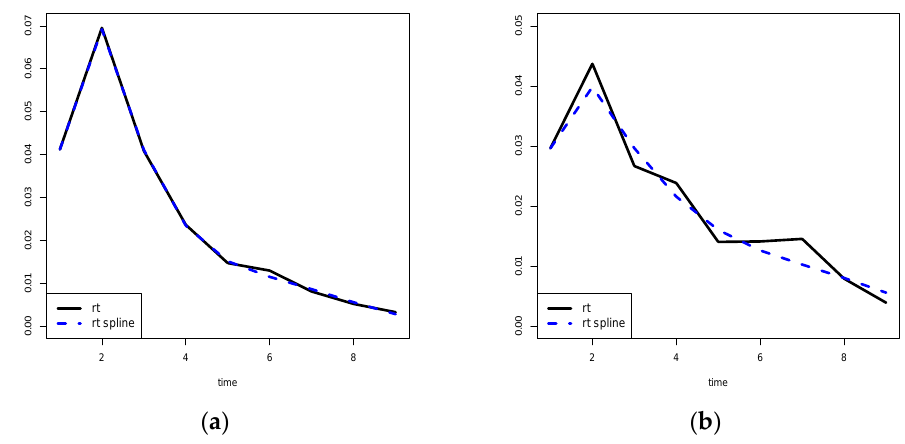
Figure 7. Recovery rate at time t ( r t ) smoothed and non-smoothed for ( a ) portfolio 1; and ( b ) portfolio 2.